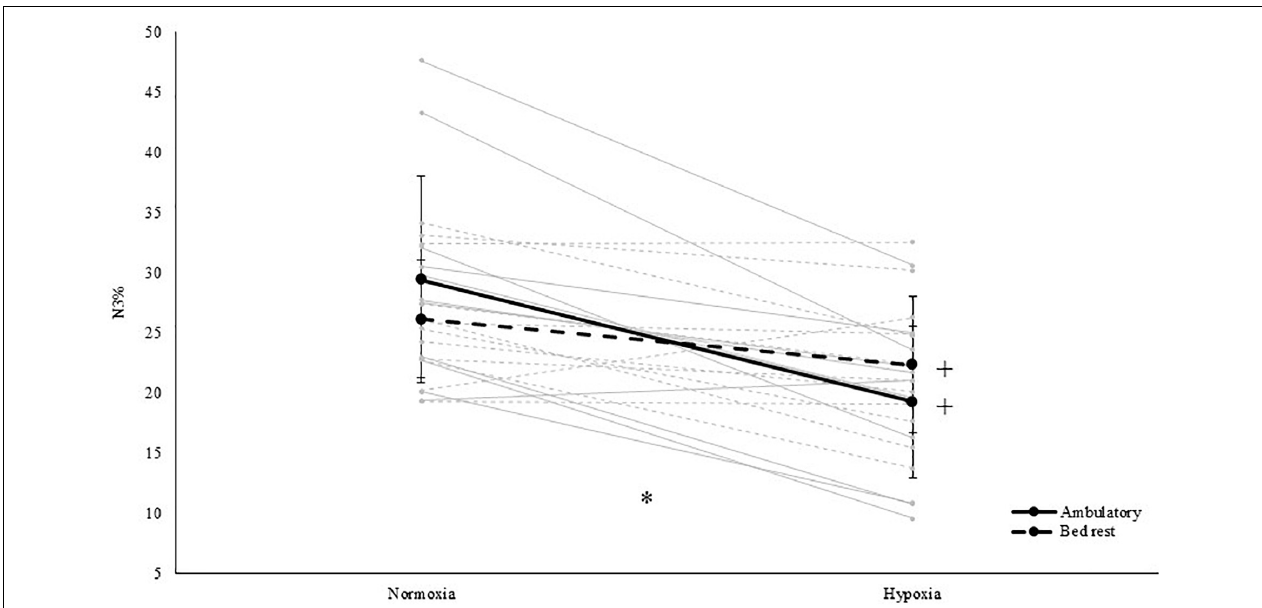
FIGURE 2 | Relative percentage of slow wave sleep (i.e., N3% of total sleep time) in both normoxia and hypoxia and when being active (i.e., ambulatory) and inactive (i.e., BR). ∗ Represents a significant interaction between activity and PO 2 . +represents a significant difference between normoxia and hypoxia in that specific level of activity. Solid grey lines represent the individual response to hypoxia in an ambulatory condition, dashed grey lines represent the individual response to hypoxia in a BR condition.